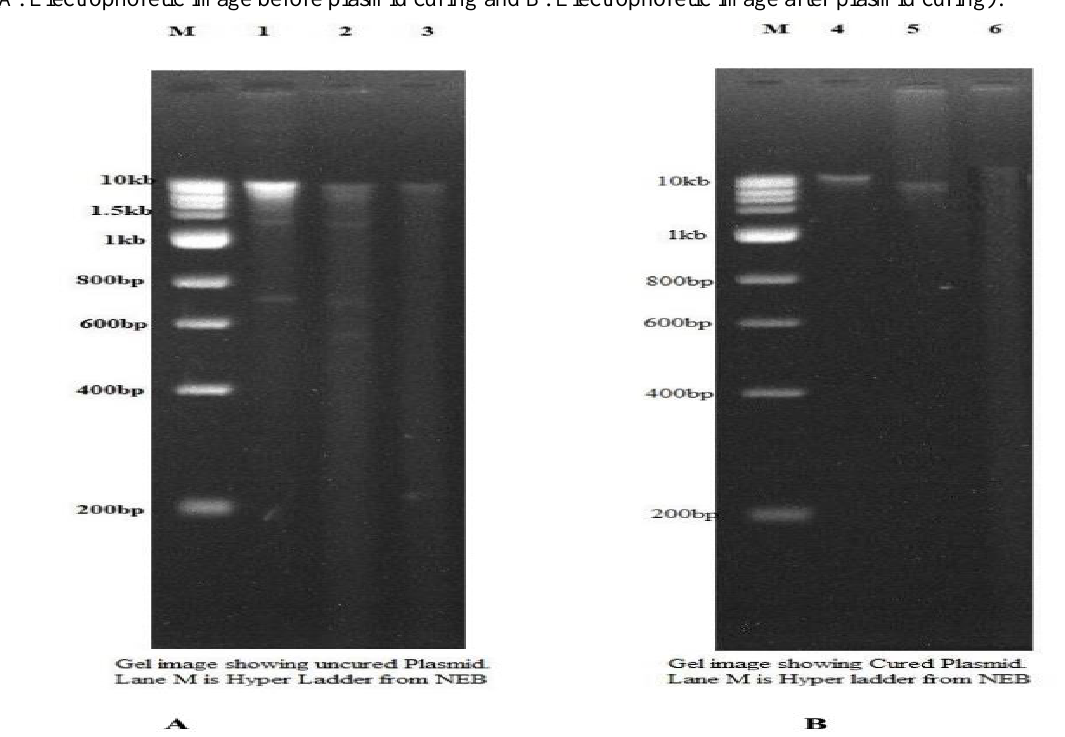
Plate 1. Electrophoretic image of plasmid DNA of the Vibrio cholerae isolates. (A: Electrophoretic image before plasmid curing and B: Electrophoretic image after plasmid